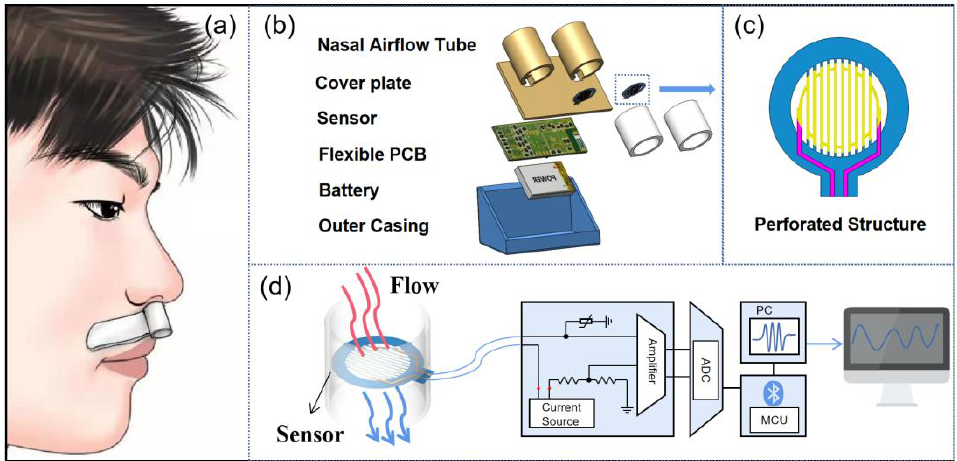
Figure 1. Schematic view of the proposed device. ( a ) Schematic diagram of wearing method. ( b ) In depth schematic illustration of the wireless sensing platform, enclosure architectures and battery. ( c ) Geometry of the perforated respiratory sensor. ( d ) Schematic representation of the sensor connected with measuring circuit and PC.